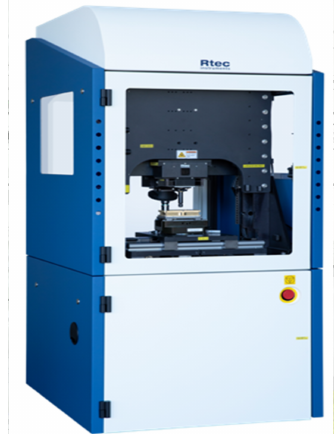
Figure 3. Friction-wear testing machine.